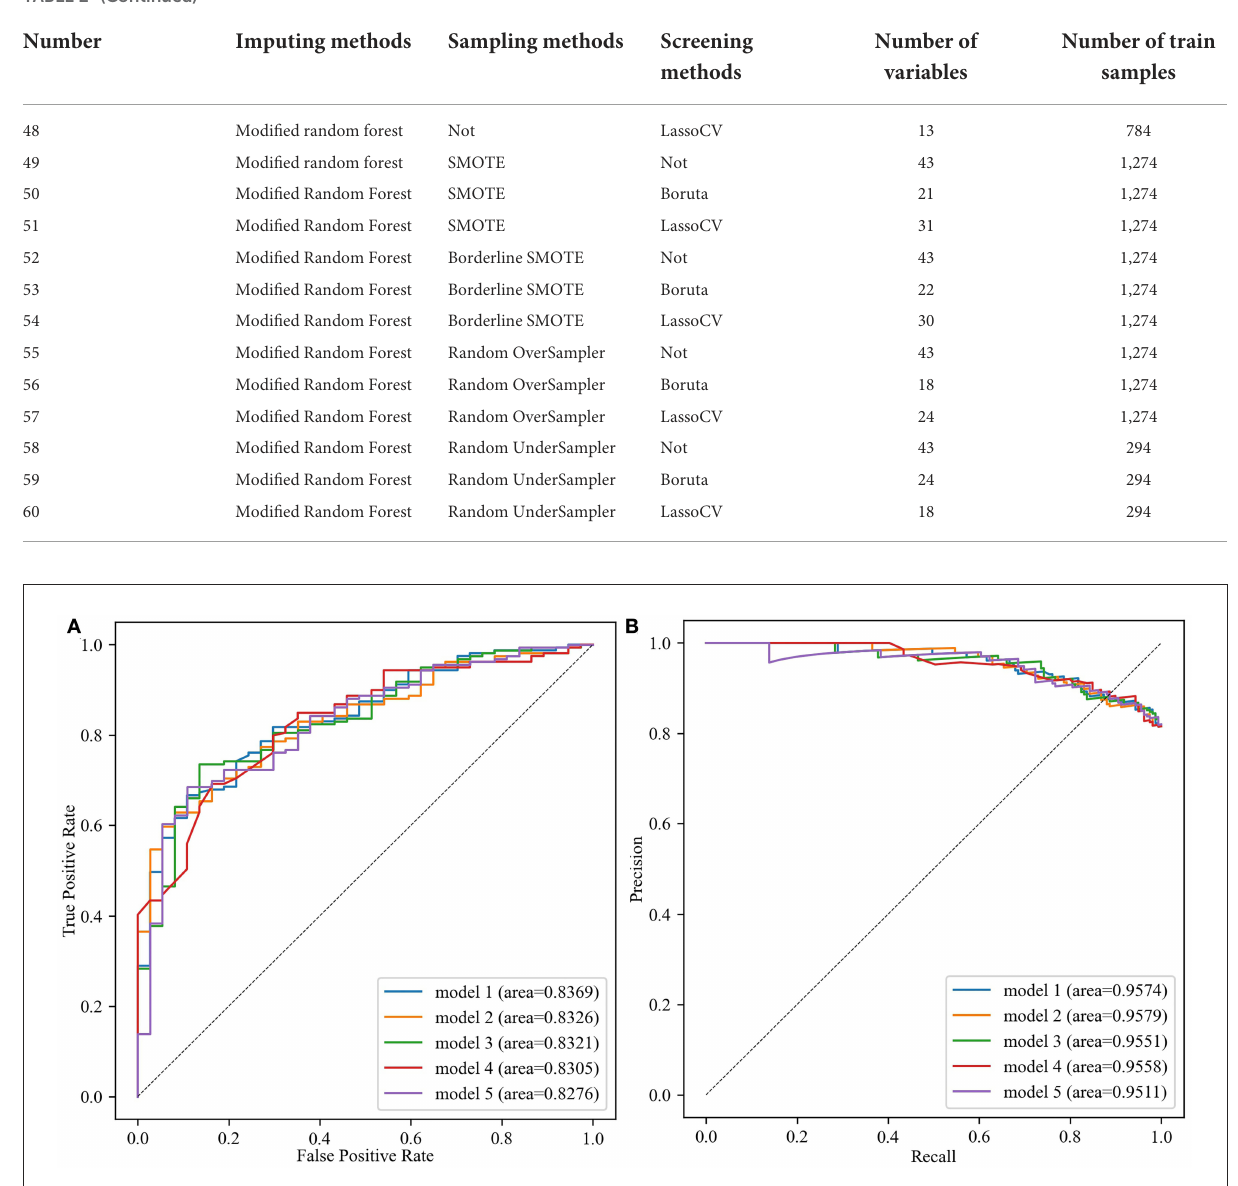
FIGURE2 The area under the receiver operating characteristic curve (AUC) and area under the precision-recall curve (AUPRC) of the best five models. (A) The receiver operator characteristic curve. (B) The precision-recall